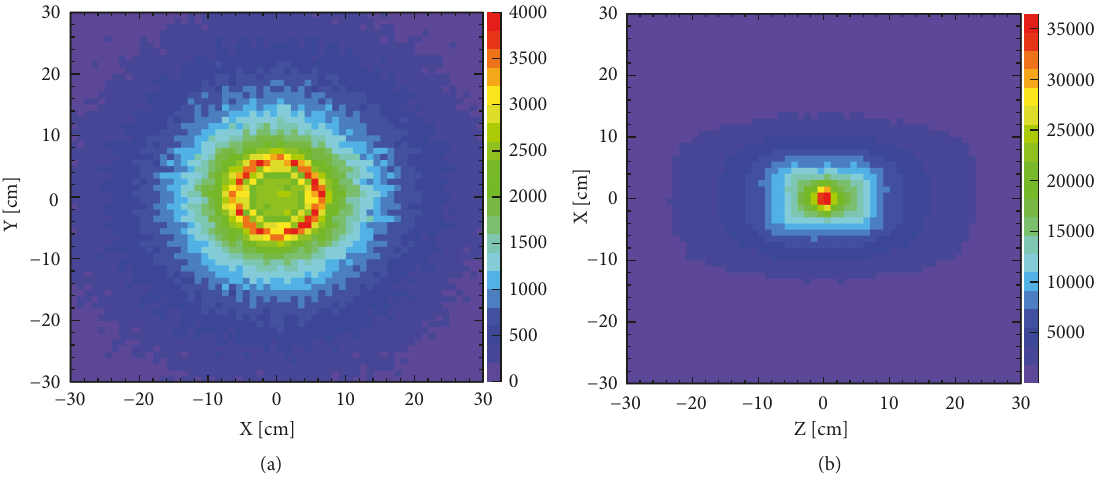
Figure9:TomographicimagesofthecylindricalchamberusedinthetestrunofJ-PET,obtainedusingreconstructed 𝑒 + 𝑒 − 󳨀→ 2𝛾 annihilation events. (a) Transverse view of the chamber (the central longitudinal region of |𝑧| < 4 cm was excluded where the image is dominated by annihilation events originating in the setup of the 𝛽 + source.). (b) Longitudinal view of the imaged chamber. In the central region, a strong image of the positron source and its mounting setup is